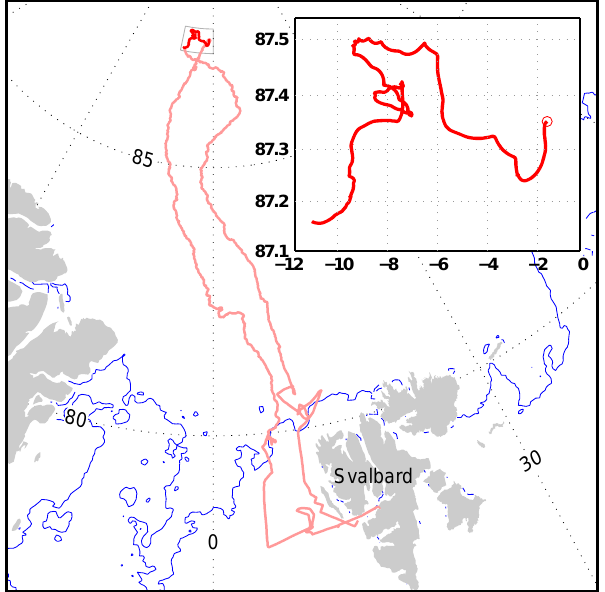
Fig. 1. Map of the ASCOS cruise track (pink) and ice drift (red). The blue line represents the approximate maximum southerly sea ice extent on 12 August 2008 (DoY 225). The insert shows the position of the icebreaker during the ice drift, where the red circle is the start